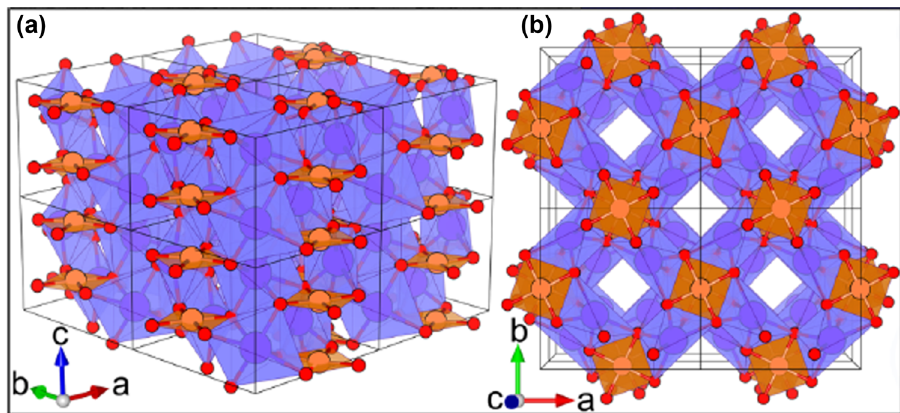
Figure 7: ( a ) Isometric and ( b ) c - axis projection of the crystal structure of CuBi 2 O 4 ( Cu – orange, Bi – purple, and O – red ) . ( Reprinted with permission from ref. [ 157 ] . Copyright © 2021, American Chemical Society ) .